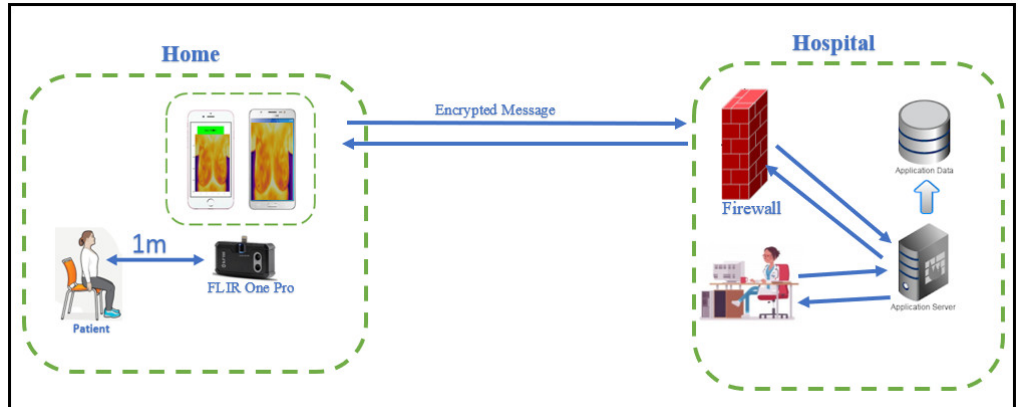
Figure 1. Self-detection of breast cancer based on smartphone application with infrared camera.